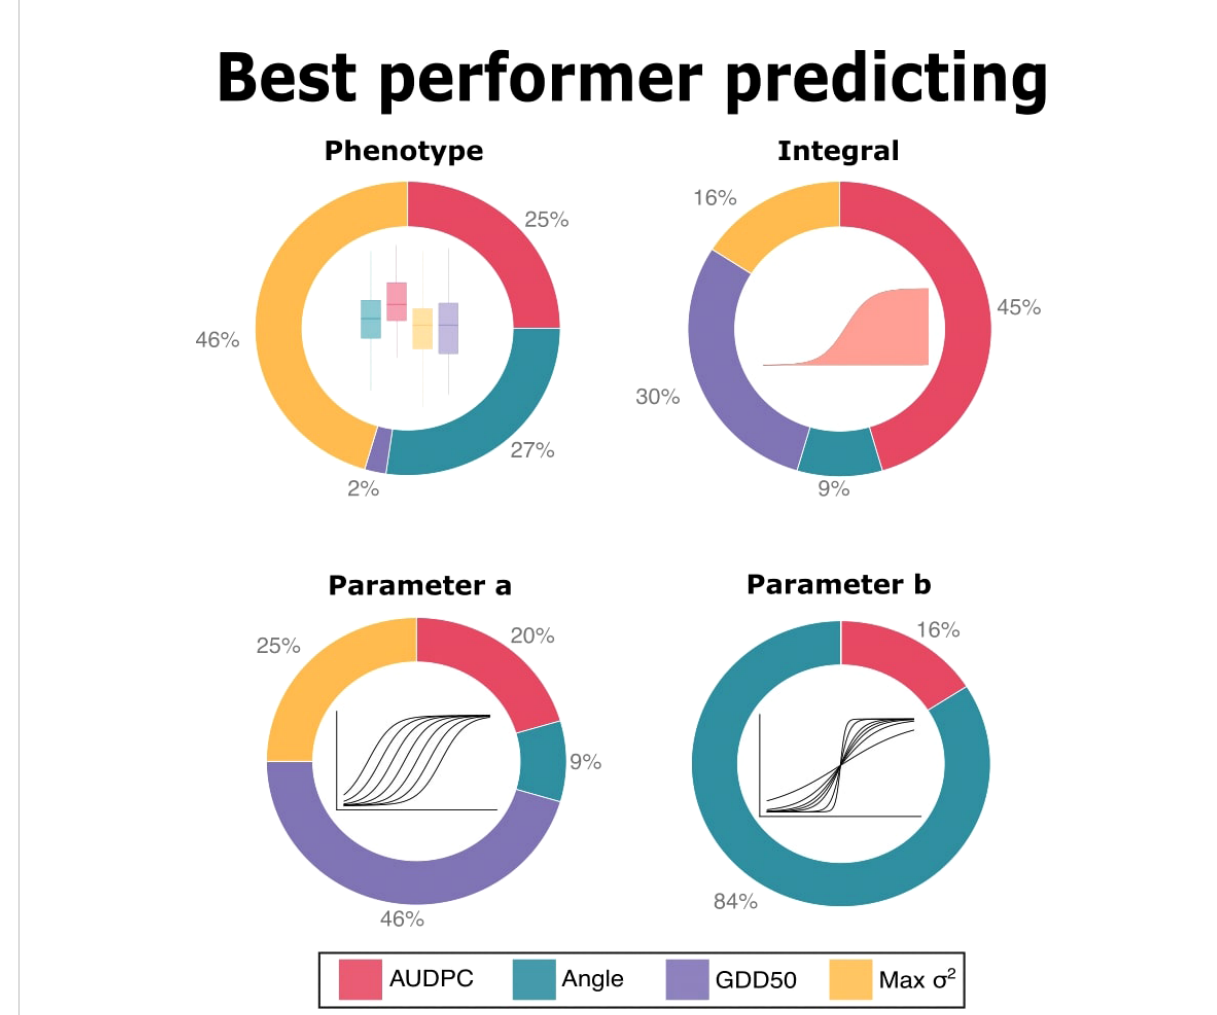
FIGURE 4 Predictive ability summary. Each chart represents the percentage of tasks in which each scoring metric obtained the best accuracy i.e. the best correlation between GEBVs and the respective parameter (in the top of each